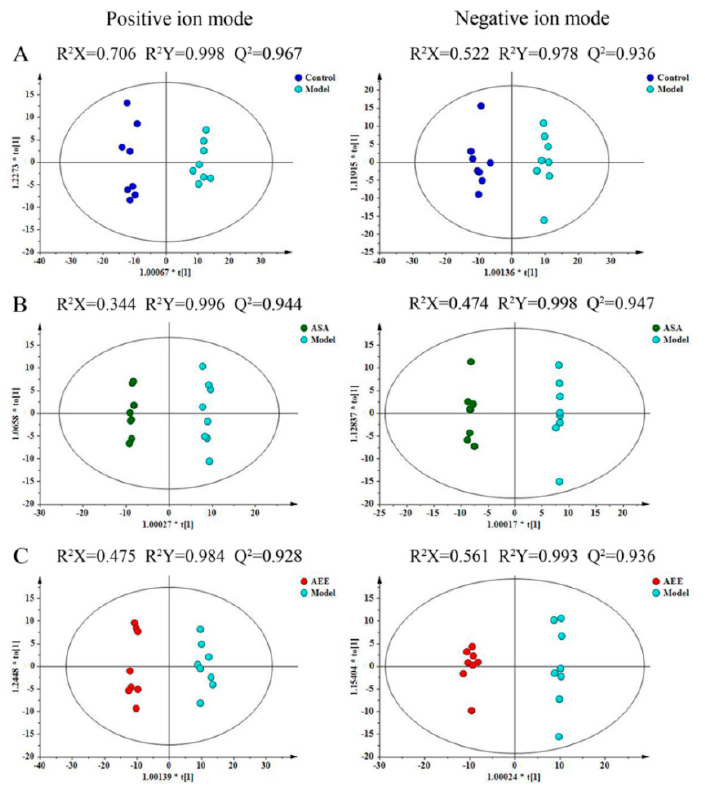
Figure 3. The effect of AEE on the metabolomic profile of plasma from rats with blood stasis. The OPLS-DA score plots of different groups in positive and negative modes. ( A ) Control group versus model group, ESI+: R 2 X = 0.706, R 2 Y = 0.998 and Q 2 = 0.967; ESI-: R 2 X = 0.522, R 2 Y = 0.978 and Q 2 = 0.936. ( B ) ASA group versus model group, ESI+: R 2 X = 0.344, R 2 Y = 0.996 and Q 2 = 0.944; ESI-: R 2 X = 0.363, R 2 Y = 0.995 and Q 2 = 0.93. ( C ) AEE group versus model group, ESI+: R 2 X = 0.475, R 2 Y = 0.984 and Q 2 = 0.928; ESI-: R 2 X = 0.494, R 2 Y = 0.976 and Q 2 = 0.912.